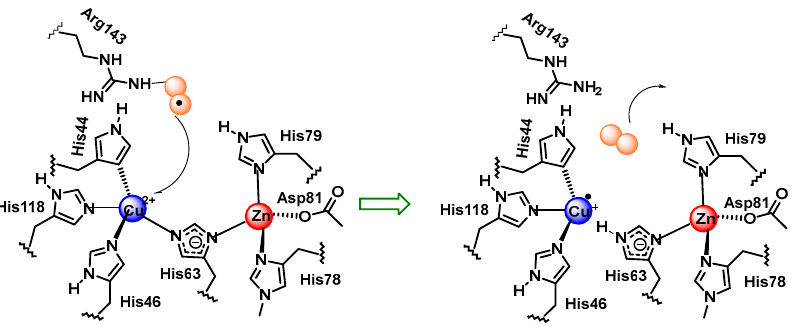
Figure 34. First phase of the reaction mediated by SOD1 with elimination of O 2 •− reduction of copper and formation of O 2 .